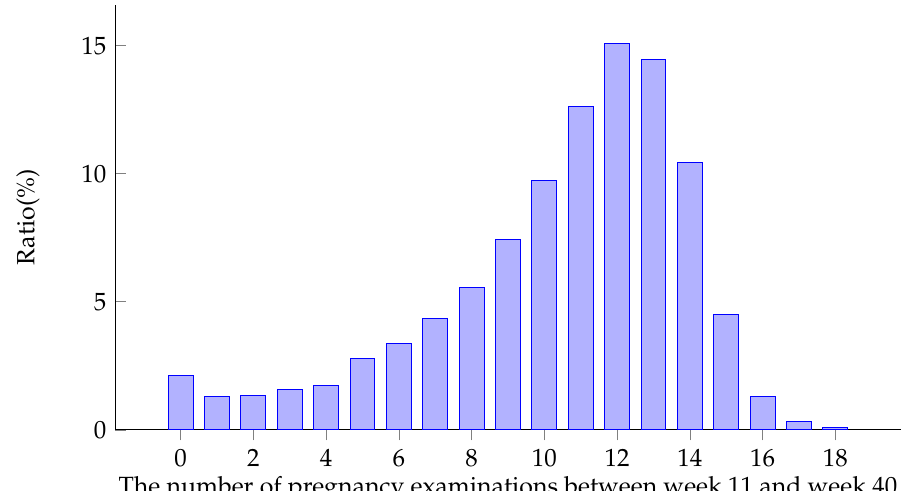
Figure 6. Distribution of physical examination times during pregnancy after preprocessing This paper selected data of a part of time as markers and selected other data as training data. The filling effect was evaluated by the prediction results and symmetric mean absolute percentage error (SMAPE) of markers. Considering the distribution of data at each time point, markers should not be selected randomly in order to prevent losing the data of important time points and severely affecting the results. This paper proposes a method described as follows: let X = x 1 , x 2 , . . ., x i , . . ., x n represent the missing state of a series of data: